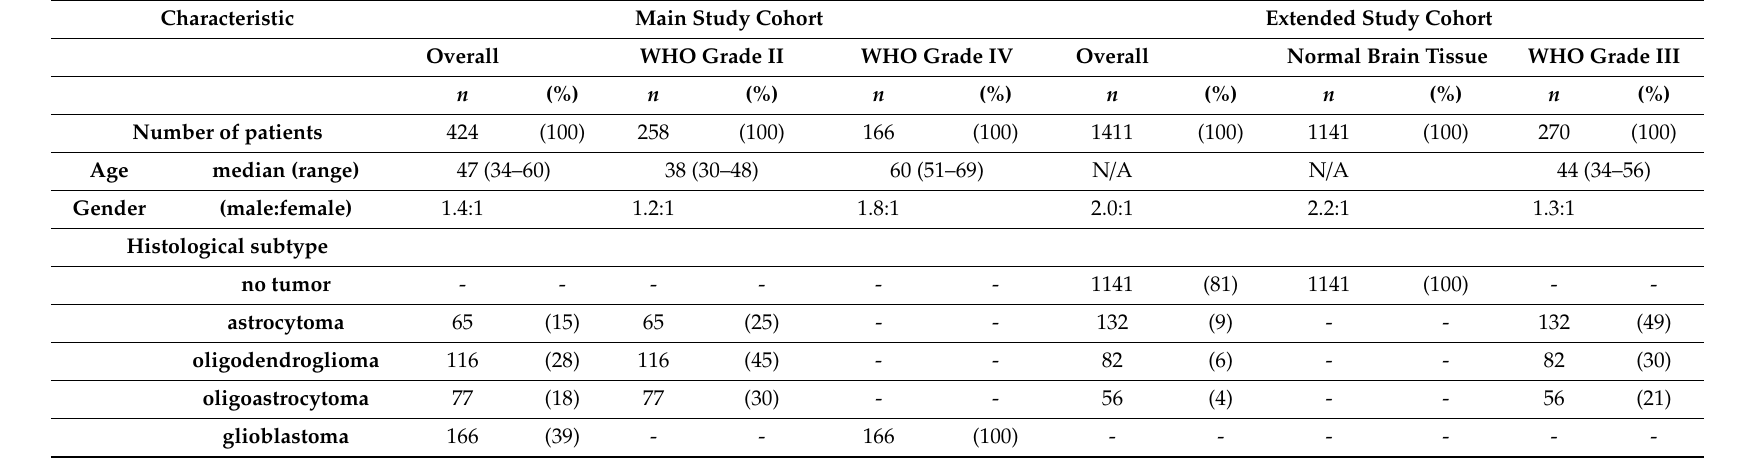
Table 1. Patient